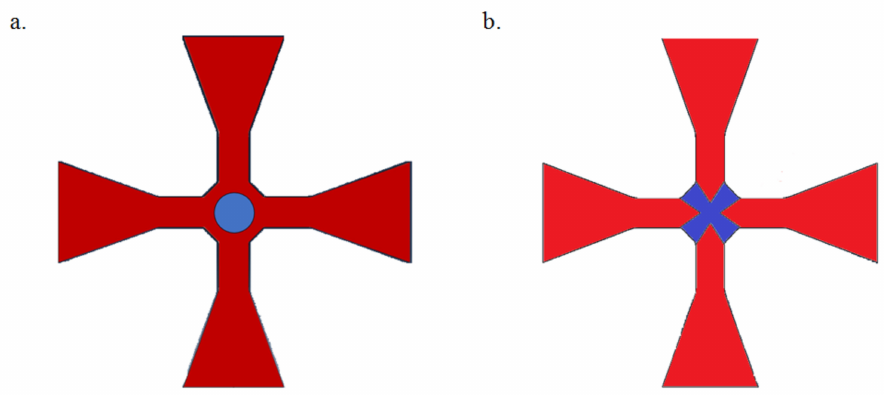
Figure 6. Drawings of the cruciform samples used for the local nitriding process (red: nitrided area, blue: non-treated area): ( a ) Specimen_1, ( b )